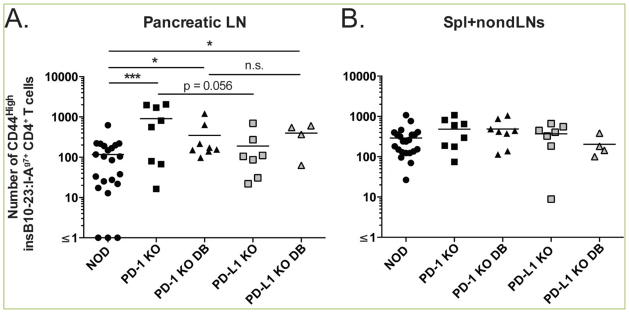
NOD PD-1/PD-L1 deficiency leads to increased activation of insulin-specific CD4+ T cellsThe frequency of activated (CD44high) insulin specific T cells was determined from (A) pancreatic lymph nodes and (B) Spleen and non-draining lymph nodes of 5–6 week old PD-1 KO (n=8), PD-L1 KO (n=4–7), and age-matched littermate NOD controls (n=22) by flow cytometry prior to or at disease onset (“DB”=diabetes) using insB10-23r3:I-Ag7 tetramer reagents. Shown are compiled data from four independent experiments.